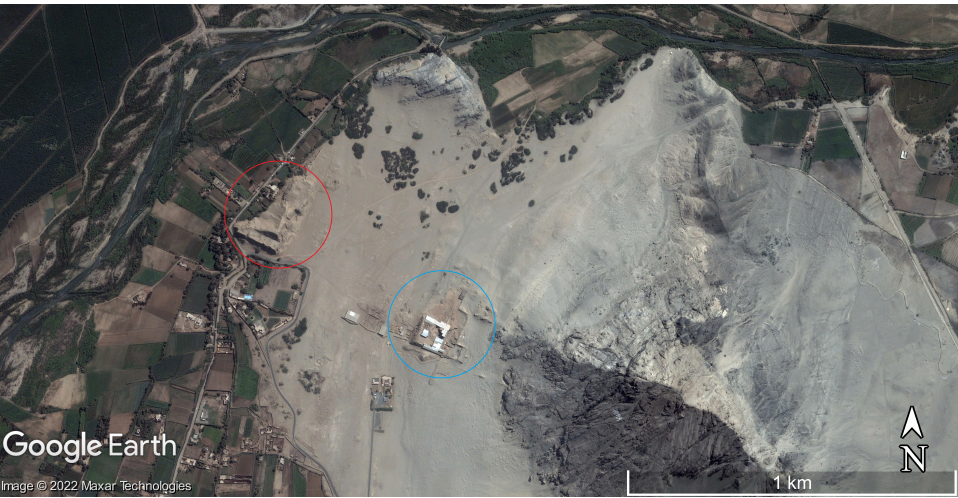
Figure 2. Huacas de Moche; 2004 satellite image (8 ◦ 07 (cid:48) 25 (cid:48)(cid:48) –8 ◦ 08 (cid:48) 22 (cid:48)(cid:48) S, 79 ◦ 00 (cid:48) 17 (cid:48)(cid:48) –78 ◦ 58 (cid:48) 35 (cid:48)(cid:48) W). Huaca del Sol and Huaca de la Luna are marked by a red circle and blue circle, respectively. The depo- sitional origin of late Holocene layers covering the plain between the monumental buildings should be ascertained, taking into account the landscape processes argued by the authors